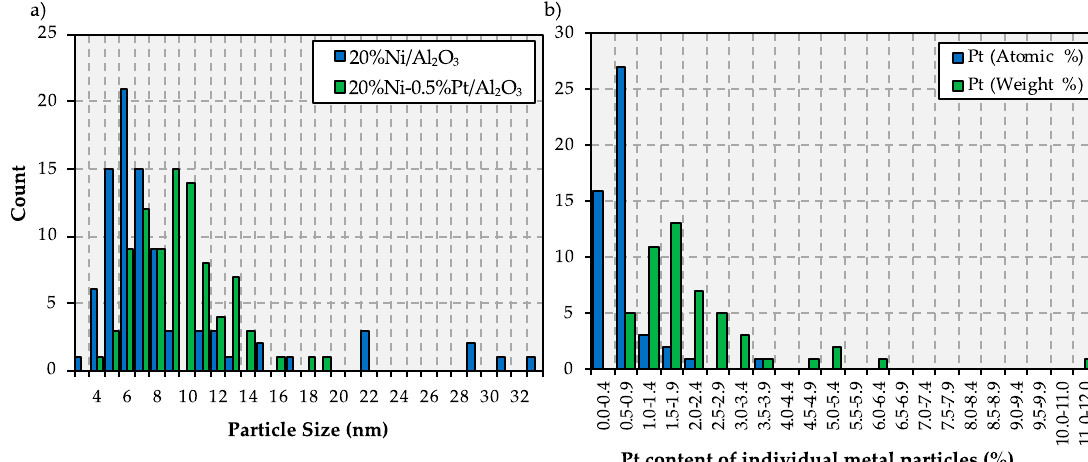
Figure 8. Particle size histograms for the spent 20% Ni-/Al 2 O 3 and 20% Ni-0.5% Pt/Al 2 O 3 catalysts ( a ) and metallic composition histograms for the spent 20% Ni-0.5% Pt/Al 2 O 3 formulation ( b ).